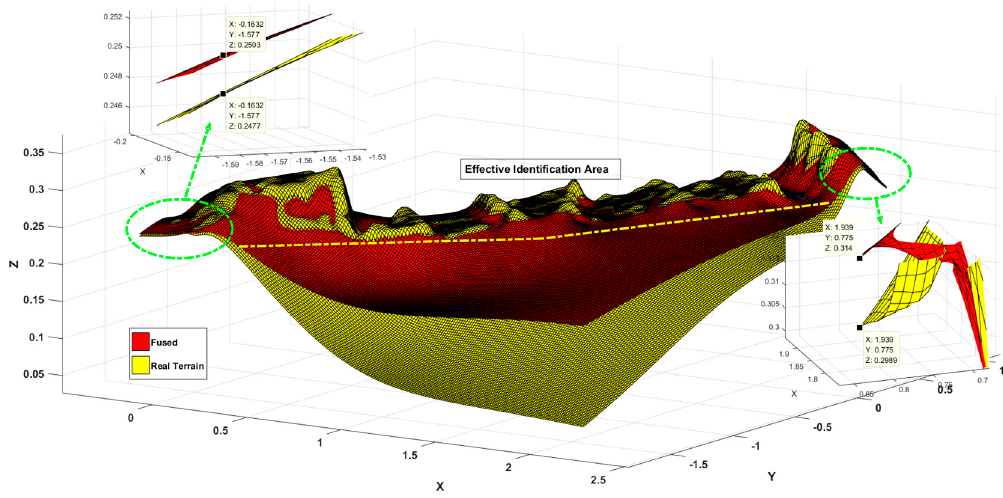
Figure 21. Comparative analysis of terrain mapping results.